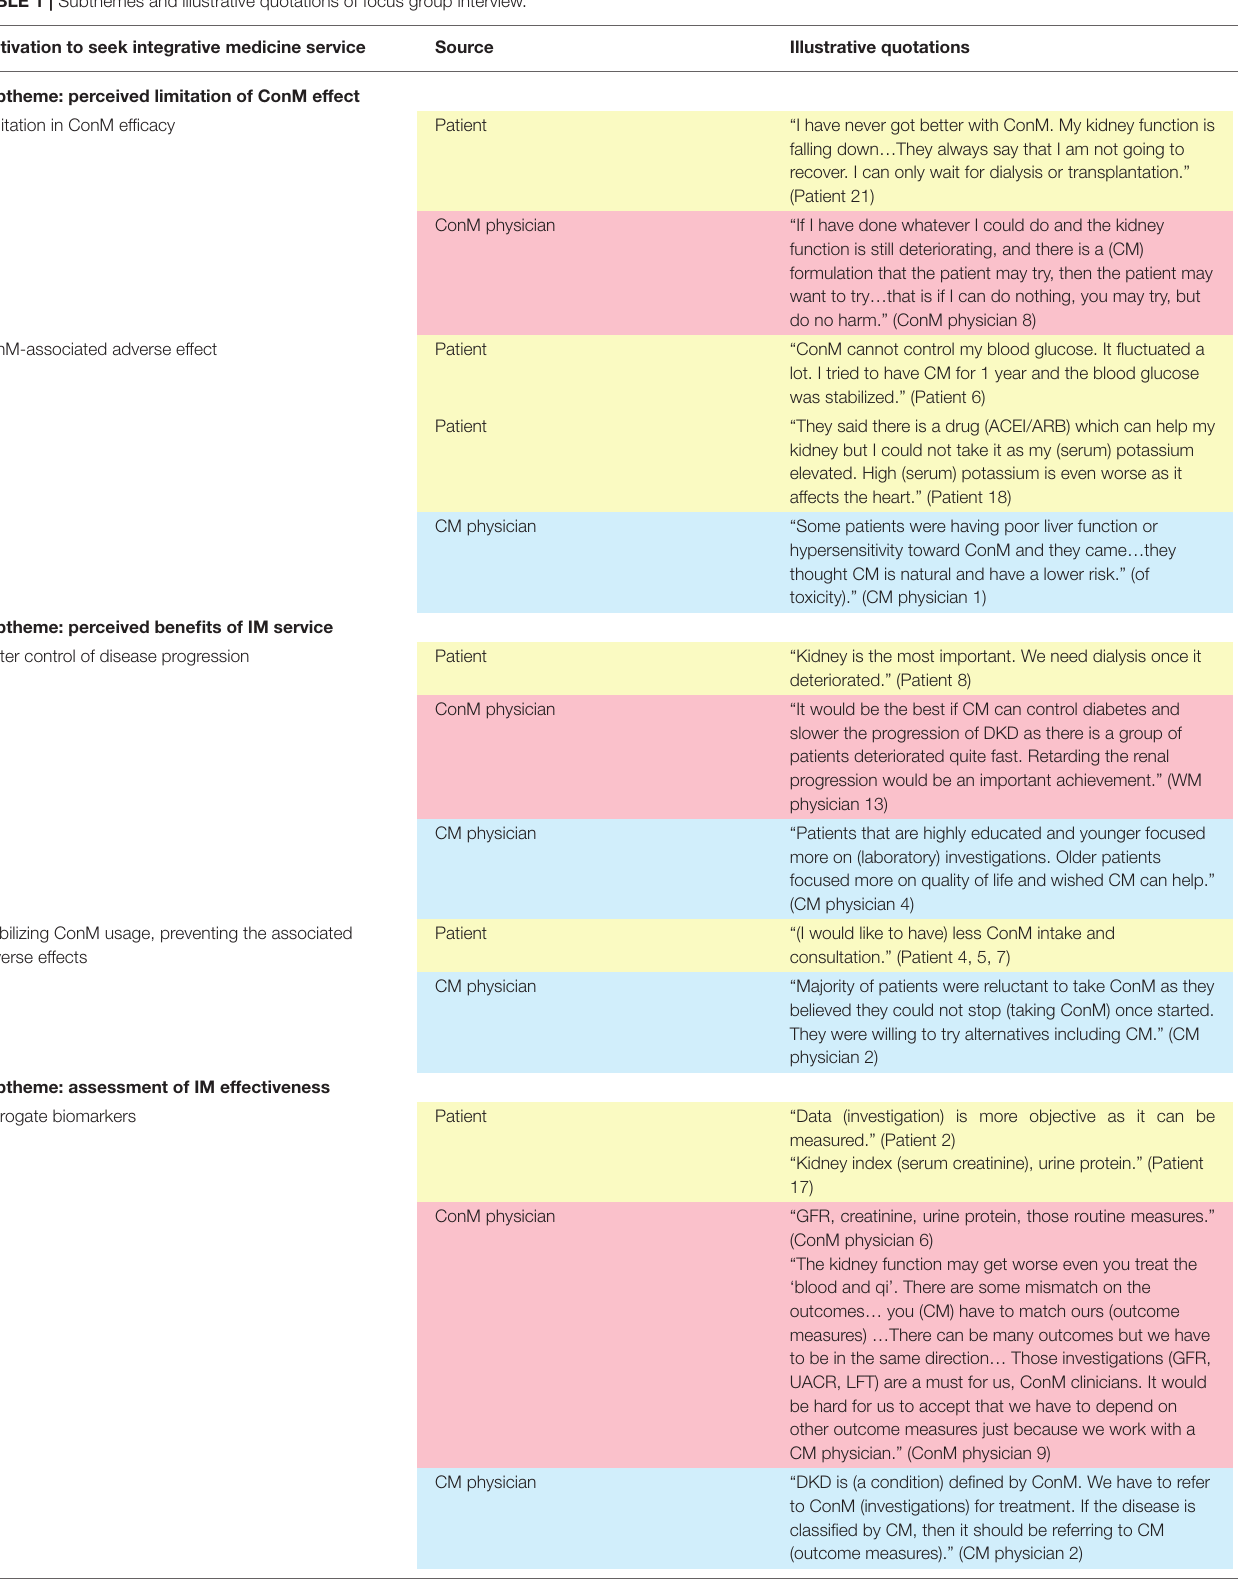
TABLE 1 | Subthemes and illustrative quotations of focus group